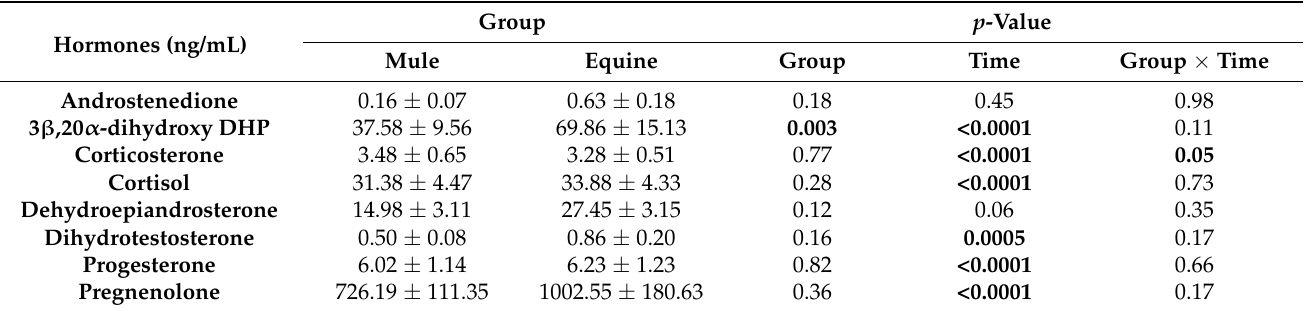
Table 1. Mean ( ± standard error) of steroid hormones from mule ( n = 6) and equine foals ( n = 6) collected during the first 12 h after